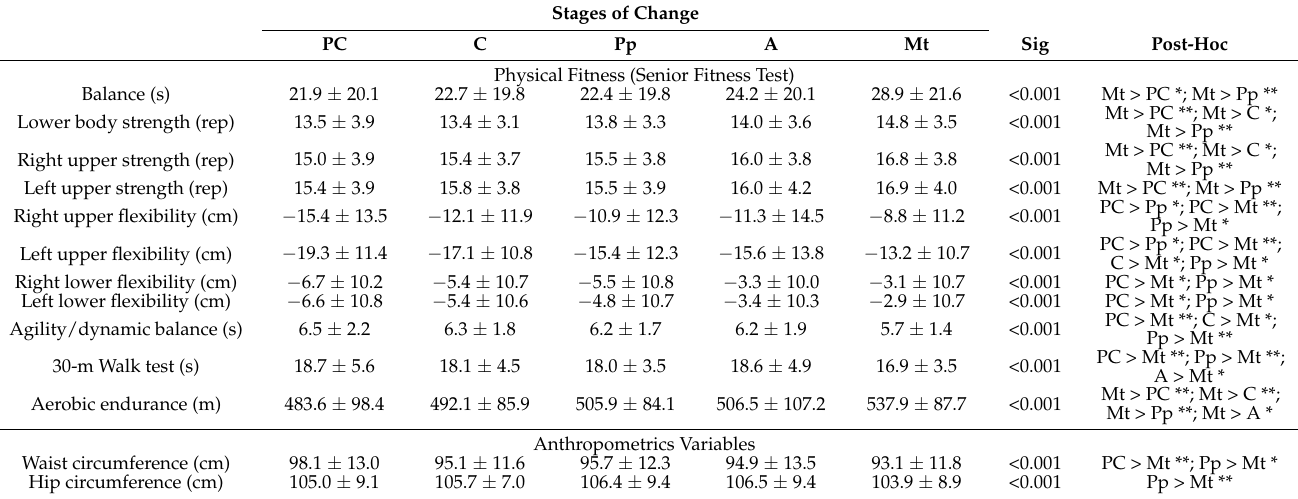
Table 2. Body composition, physical fitness level, and stages of change for physical activity. Bivari- ate